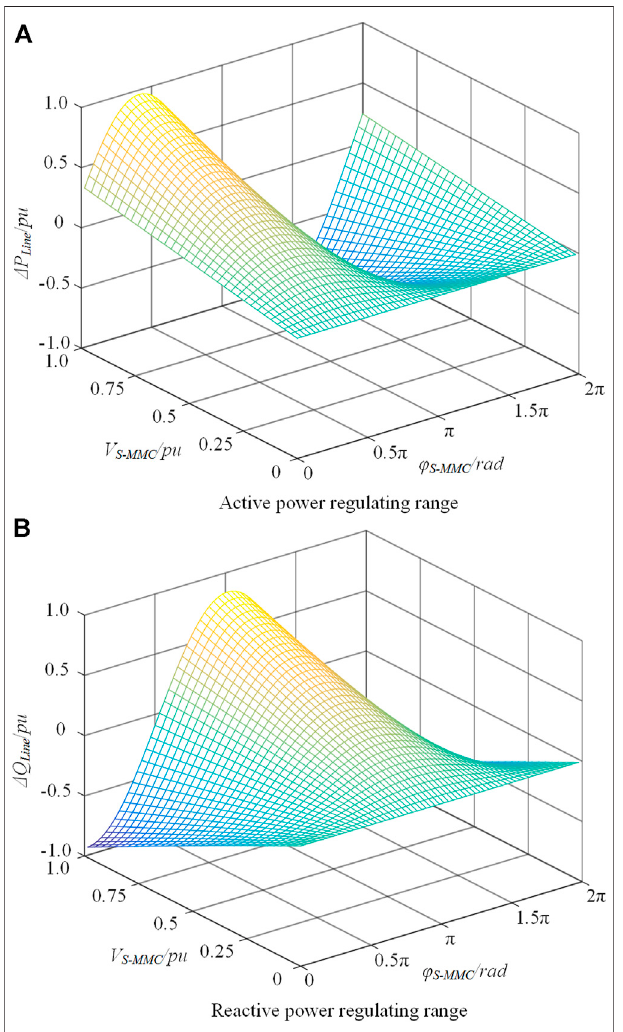
FIGURE 6 | Ideal power fl ow regulating range in balanced power grid.